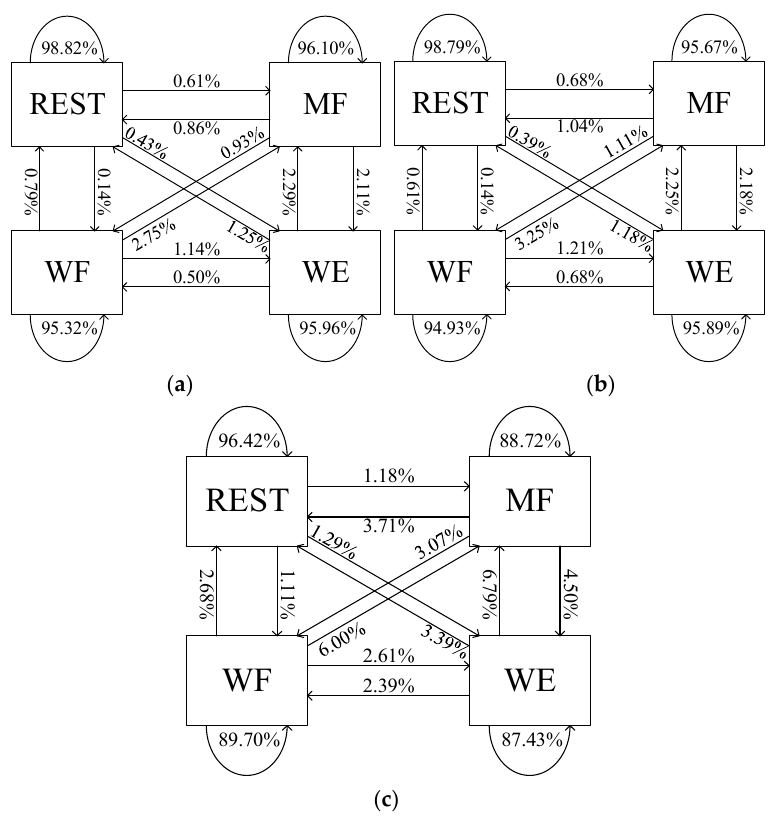
Figure 11. Recognition rate of the RF and confusion graph of different feature subsets: ( a ) the FD-based features; ( b ) the RFE-based features; ( c ) the APWC features. The numbers denote the percentage of samples in the class (arrow tail) classified as the class (arrowhead).